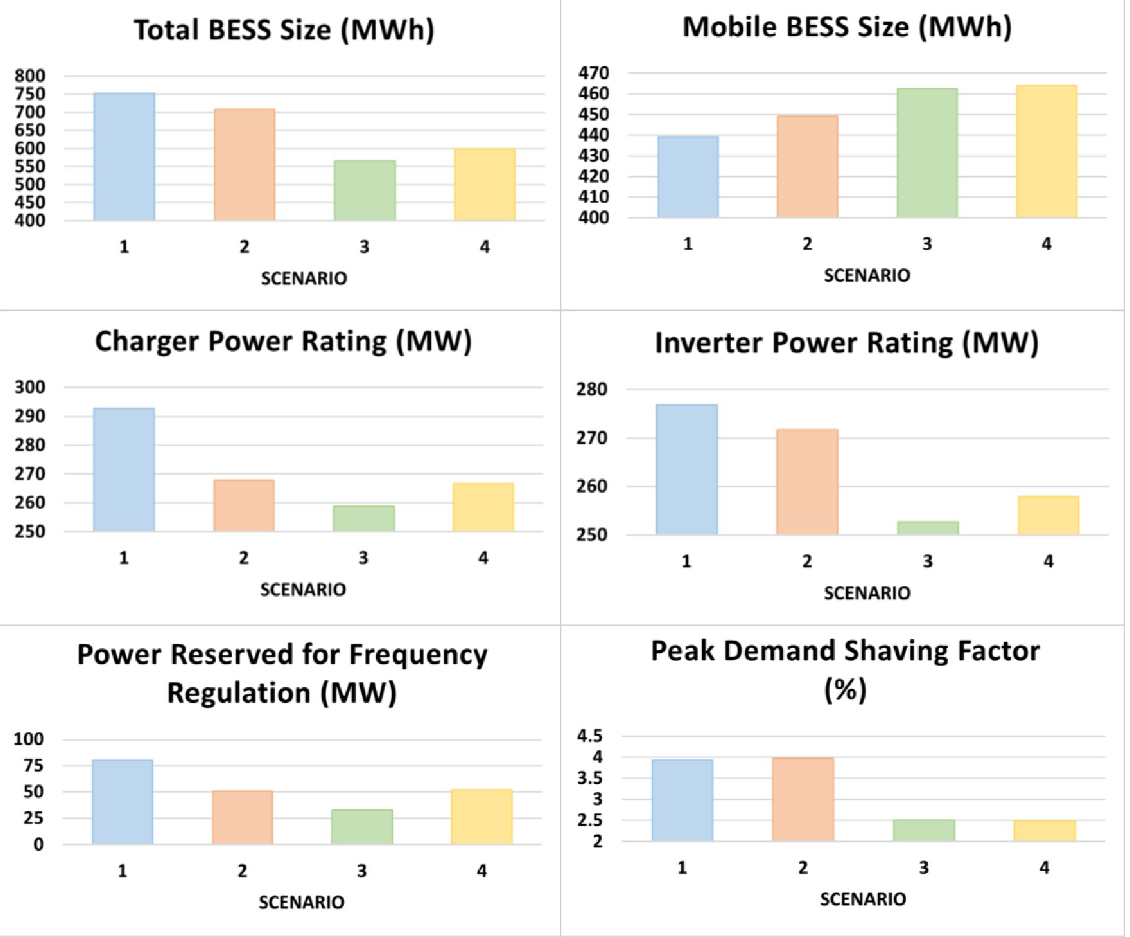
Fig 8. Optimized sets of the six control variables in four different scenarios (1, 2, 3, 4) under the DC priority operation mode.